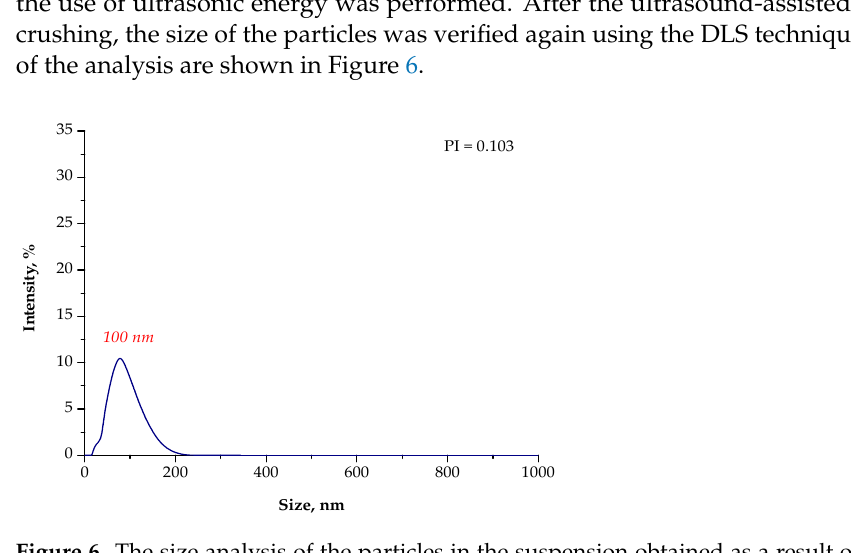
Figure 5. Types of stabilization of particles, i.e., steric ( a ) and depleted ( b ).